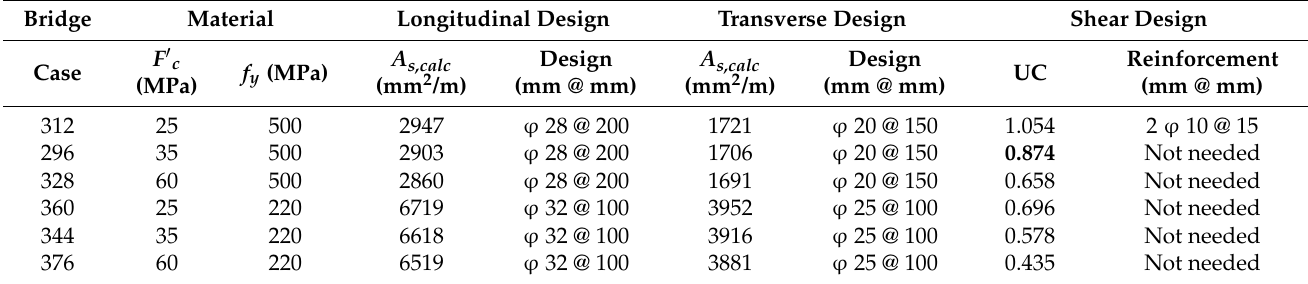
Table 6. Designed reinforcement for the 15 m long, two-lane, 45 ◦ skew case study bridge using LFEA when varying the material